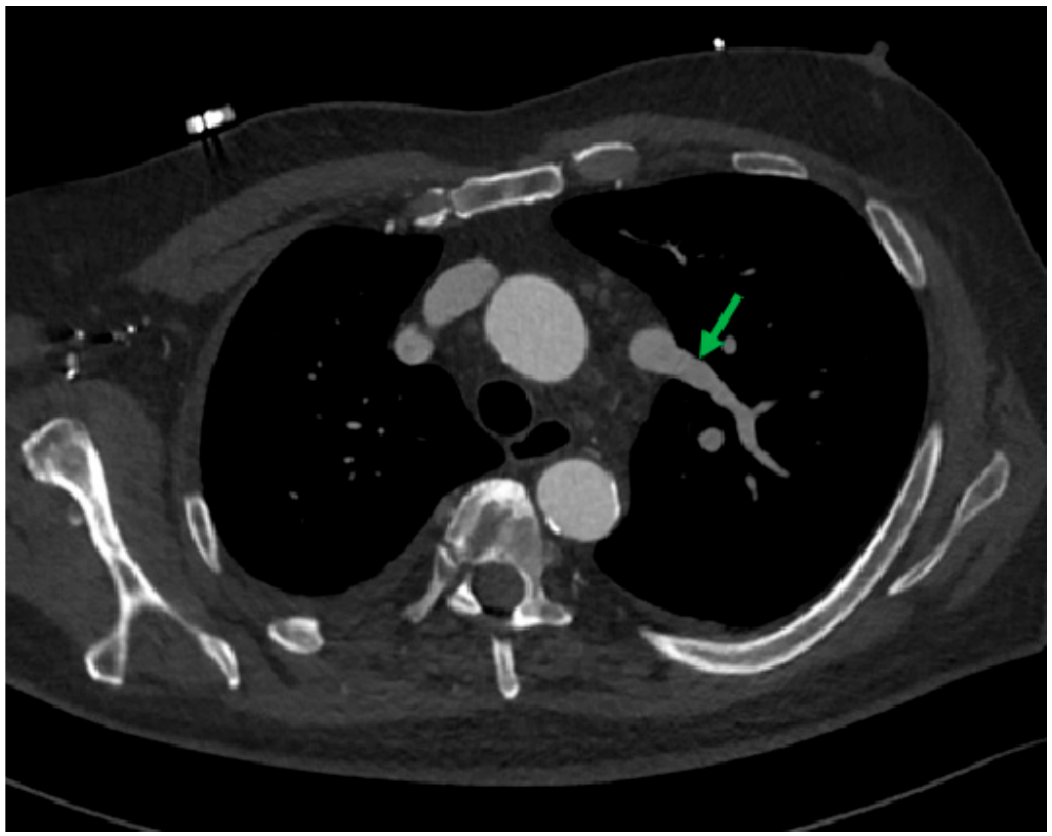
Figure 7. Unusually upward left superior pulmonary vein.